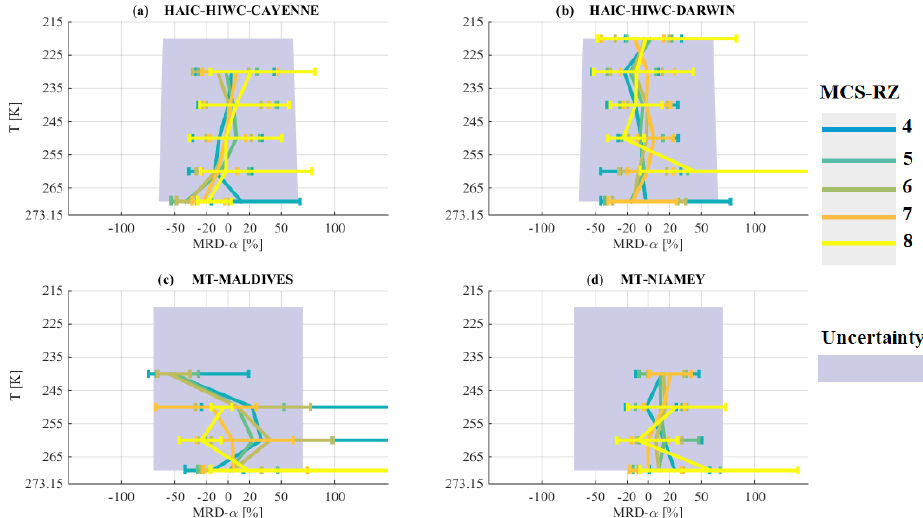
Figure 16. The same as Fig. 6 but for the pre-factor of mass–size relationship MRD- α